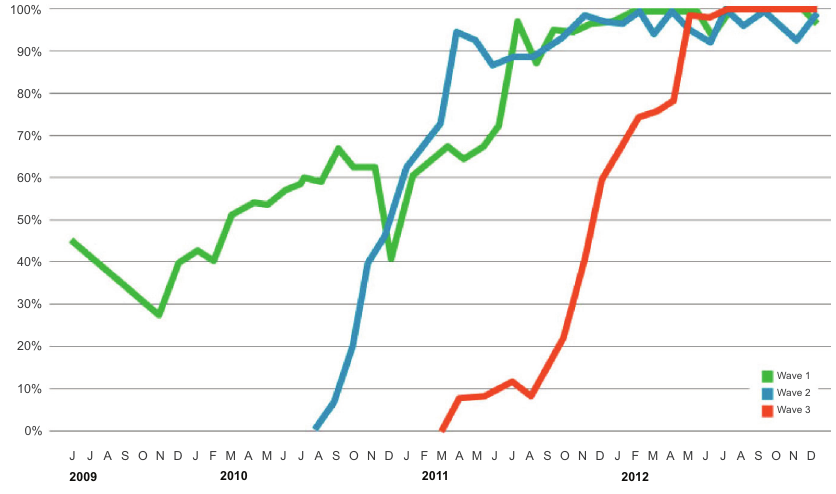
Figure 5. Afghanistan: compliance with Active Management of Third Stage of Labor (AMTSL). The rate of adoption of AMTSL in waves 2 and 3 was significantly faster than in the initial